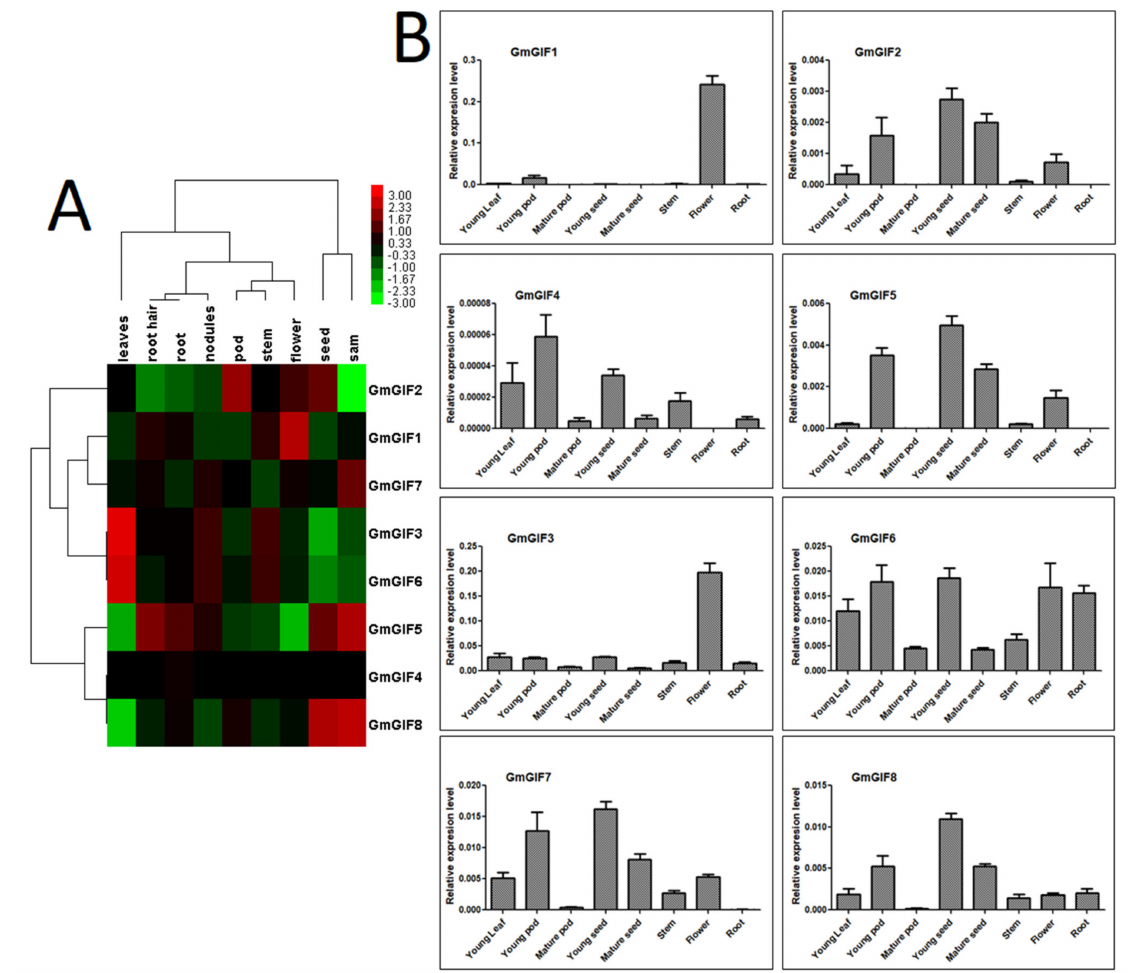
Figure 5. The soybean GIFs gene expression patterns in different tissues. ( A ) The Phytozome V12.1 database was used to obtain data on the expression pattern of eight GmGIF genes across various tissues. The color scale bar and the tissue types are listed on top. The gene names are shown on the right side of the heatmap. The relative signal value level is shown at the top of the heatmap. ( B ) RT − qPCR data on the expression patterns of eight soybean GIF genes across numerous tissues. The x -axis represents the time points, and the y -axis shows the relative expression